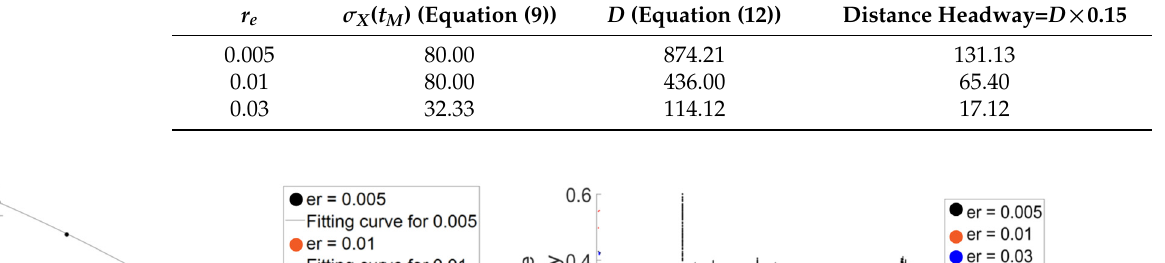
Table A1. Data for distance headway prediction based on evaporation rate ( r e ) . 𝒓 𝒆 𝝈 𝑿 (𝒕 𝑴 ) (Equation (9))